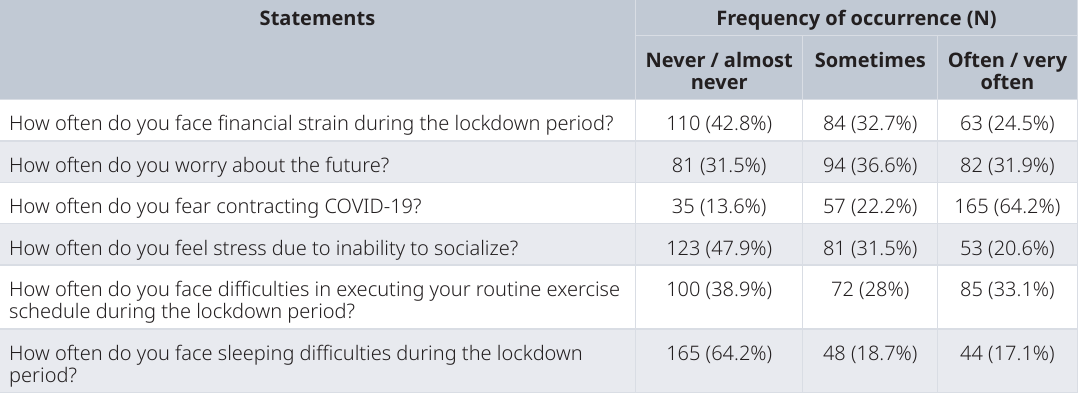
Table 2. Psychosocial impact of COVID-19 (rated on a Likert